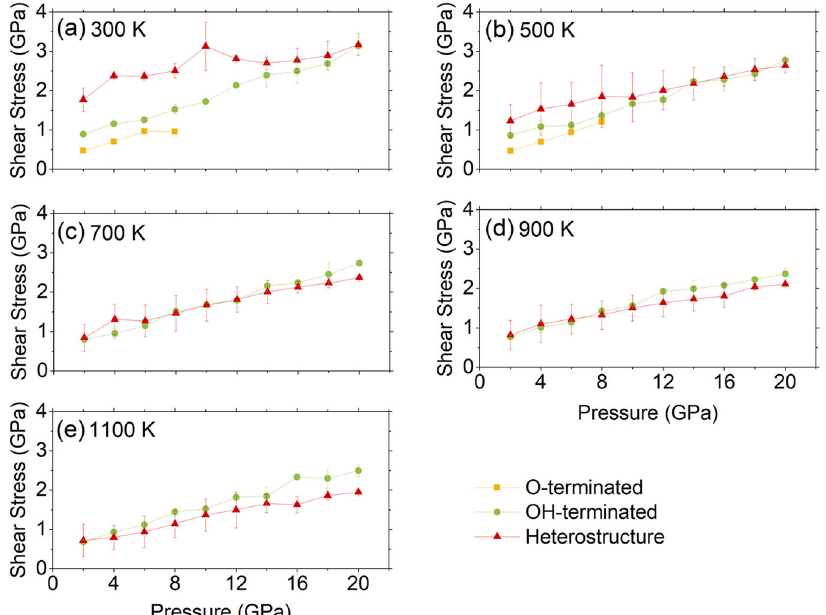
Fig. 4 Shear stresses at conditions without MXene failure. Shear stress between O-terminated, OH-terminated, and heterostructure MXenes as a function of pressure at a 300, b 500, c 700, d 900, and e 1100 K for conditions at which no failure occurred. The error bars re fl ect the standard error of three sliding cycles.